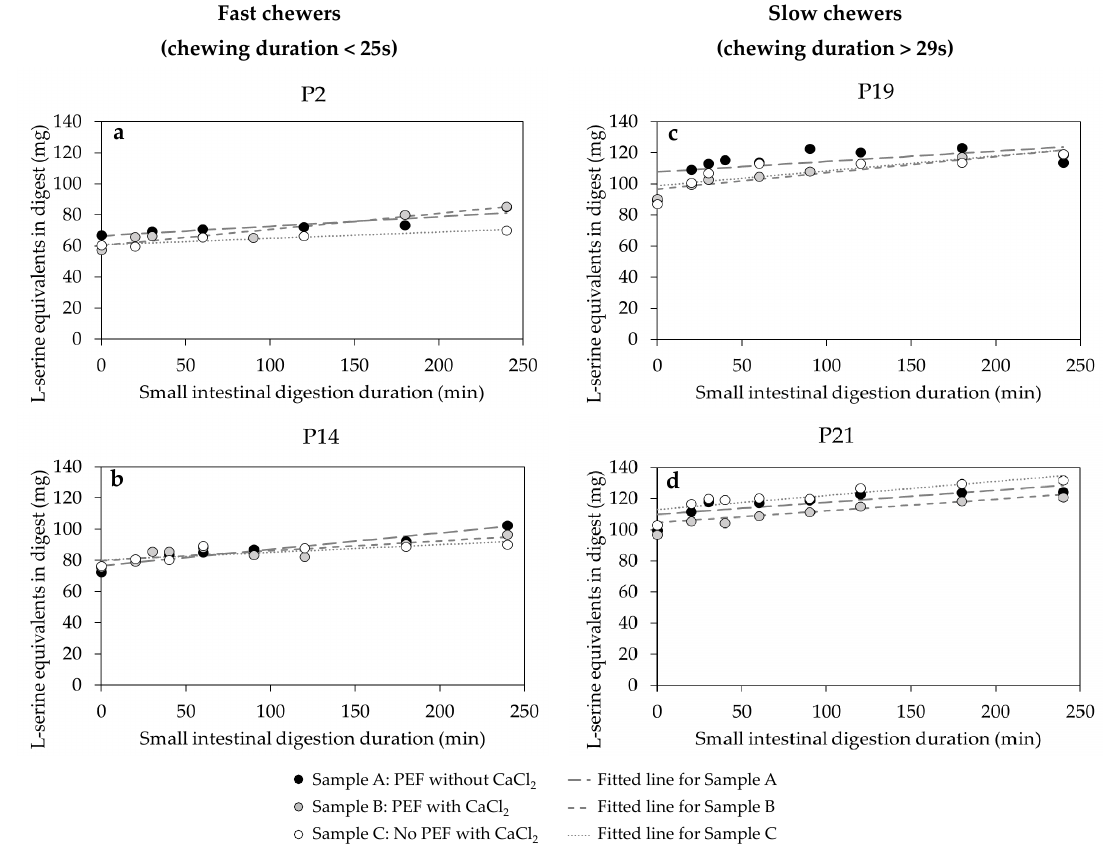
Figure 11. Kinetics of in vitro protein digestion (small intestinal phase) of in vivo masticated oral boluses of three cooked black bean samples (A: PEF and thermally processed without CaCl 2 addition; B: PEF and thermally processed with CaCl 2 addition; and C: No PEF, thermally processed with CaCl 2 ) from selected fast ( a , b ) and slow ( c , d ) chewers. Experimental data are represented by circle markers and predicted values are shown in lines. All protein digestion data did not fit into a fractional conversion model and was fitted with a zero-order kinetic model (Equation (7)) instead. Table 5. Estimated rate of in vitro small intestinal protein digestion k p (× 10 − 2 min − 1 ) of in vivo mas- ticated oral boluses of the black bean samples (A: PEF and thermally processed without CaCl 2 addition; B: PEF and thermally processed with CaCl 2 addition; and C: No PEF, thermally pro- cessed with CaCl 2 ) from selected fast and slow chewers.